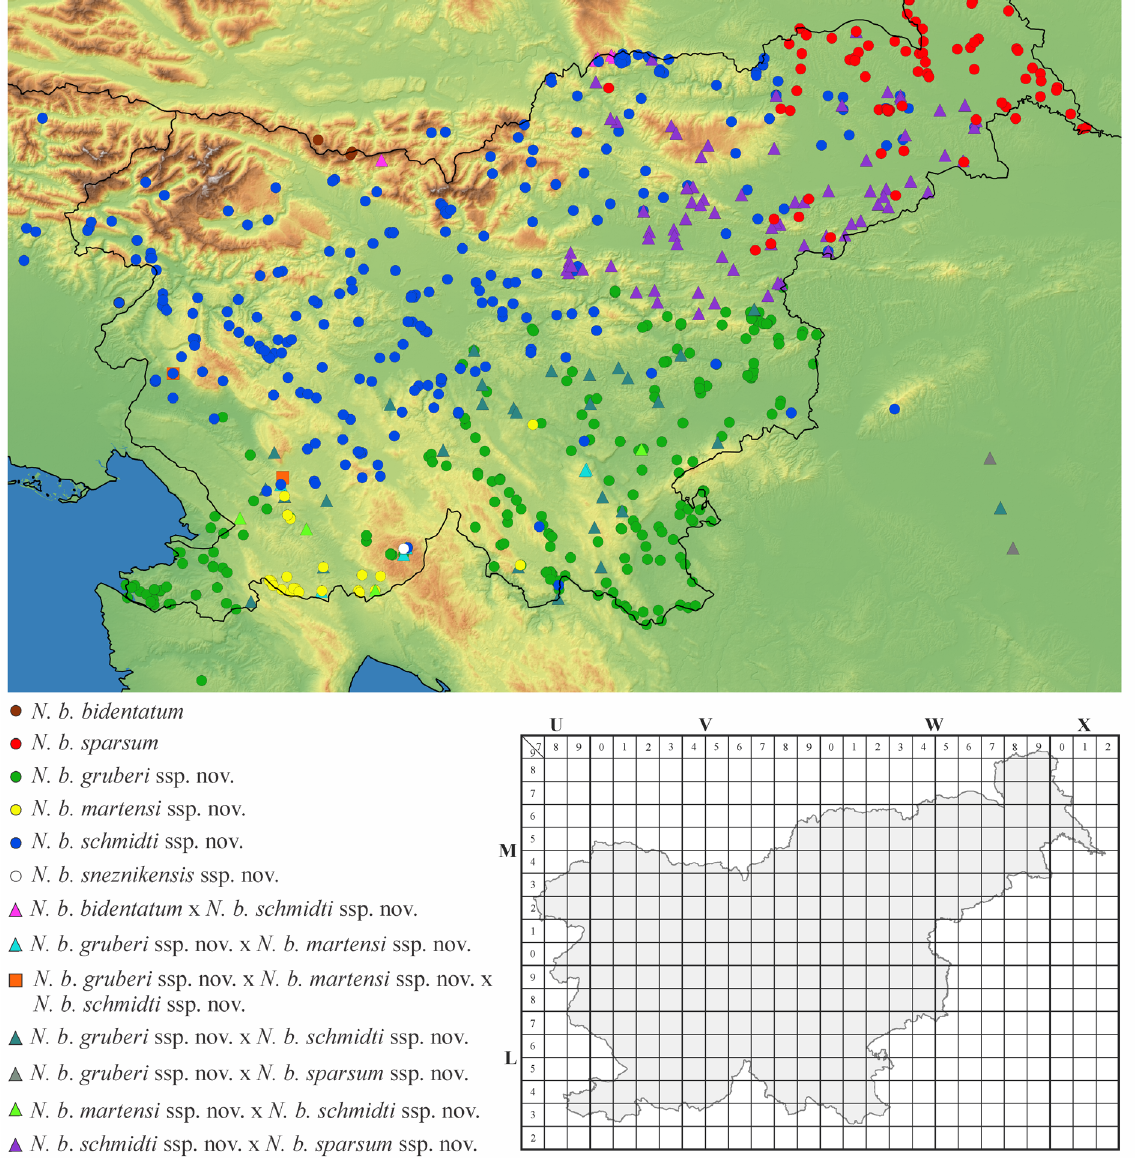
Fig. 3. Distributional areas of six subspecies (circles) and hybrids (triangles, squares) within the Nemastoma bidentatum Roewer, 1914 in Slovenia and adjacent regions. Note that many localities overlap on the